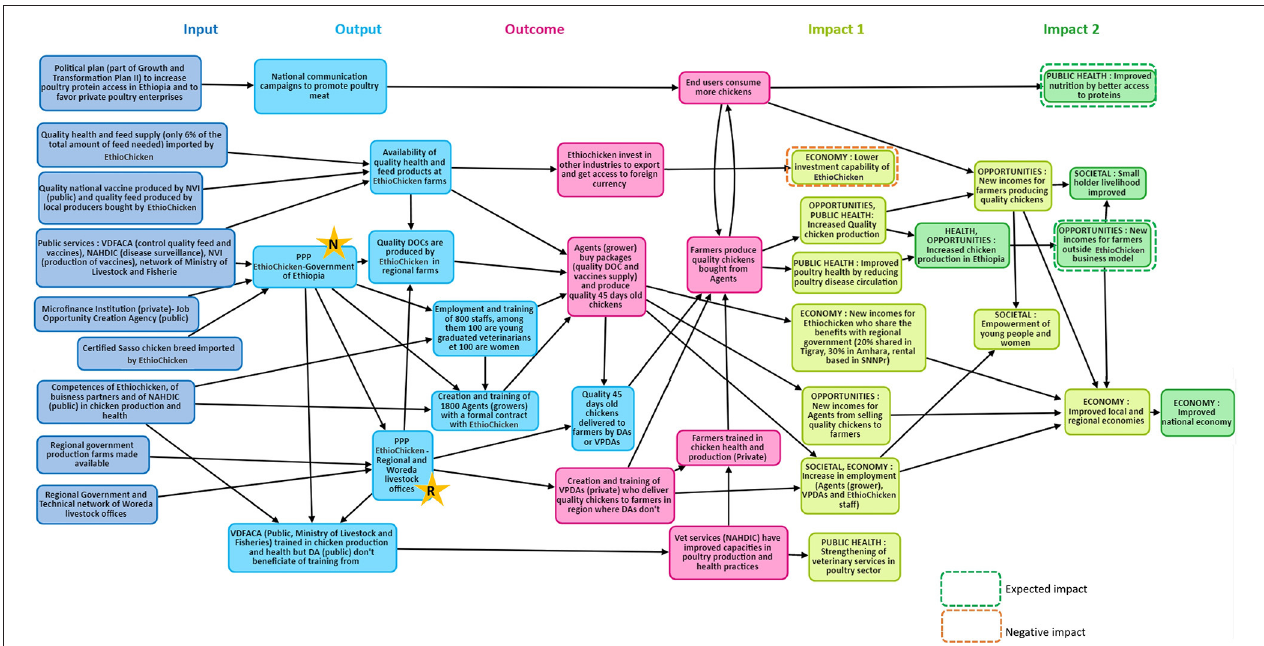
FIGURE 5 | Impact pathway of EthioChicken innovative model and PPP involved in this model: inputs (dark blue), outputs (light blue), PPP at national level (star with N), PPP at regional level (start with R); outcomes (pink), and impacts level 1(light green) and impacts level 2 (dark green). The impacts can be negative (rectangle with dotted red border) or positive (the others). DA, public development agents; DOC, day-old chicks; EC, EthioChicken; NAHDIC, National Animal Health Diagnostic and Investigation Center; NVI, National Veterinary Institute; PANVAC, Pan African Veterinary Vaccine Center of the African Union; VDFACA, Veterinary Drug and Animal Feed and Administration Control Authority; VPDA, Village Poultry Development Agents; Woreda, regions.